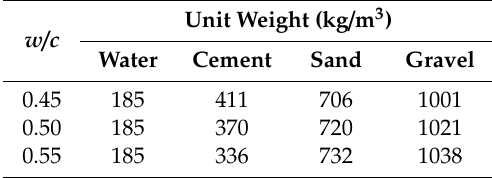
Table 1. Mixing condition of concrete used for